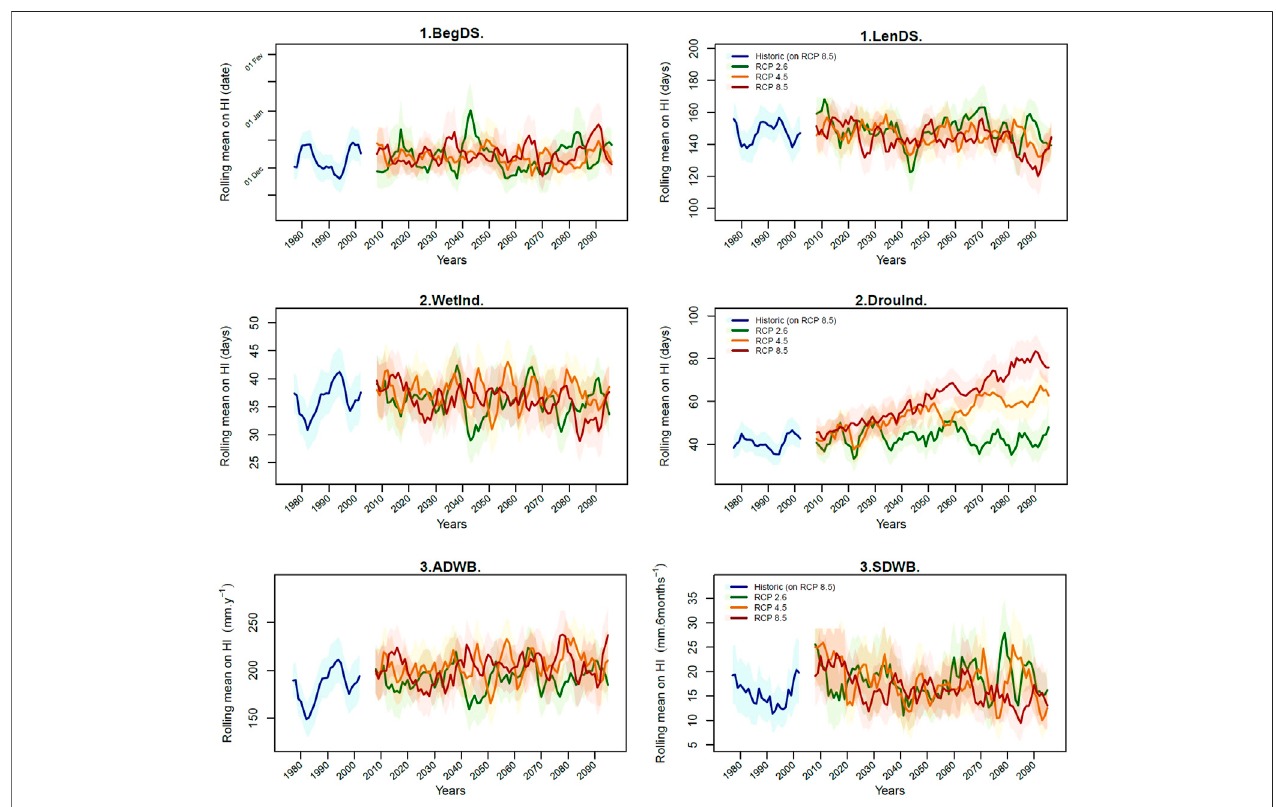
FIGURE 5 | Temporal trend of the rolling means of HIs for the fi rst three HI classes “ Temporality of the drainage season ” , “ Water content in the storage ” and “ Drained waterbalance ” inhistorical(HI CP_HIST )and futureCPs(HI CP_FUTURE ) perRCPcompared totherollingmeans fromthehistorical period.HInamesreferringtothe plots are available in Table 2 . For each tick on the x -axis, the value represents the 5-years rolling period centred on this